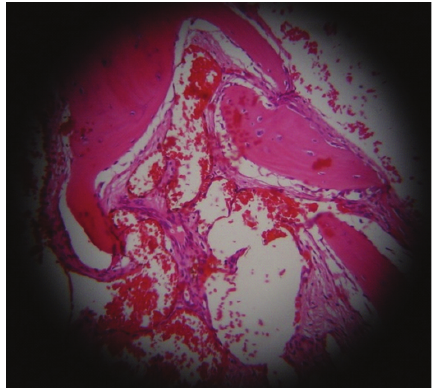
Figure 3: Histological examination: Mass that composed of blood- filled, thin-walled vessels between the bony trabeculae. The lesion was diagnosed as intraosseous cavernous hemangioma. (H&E; ×